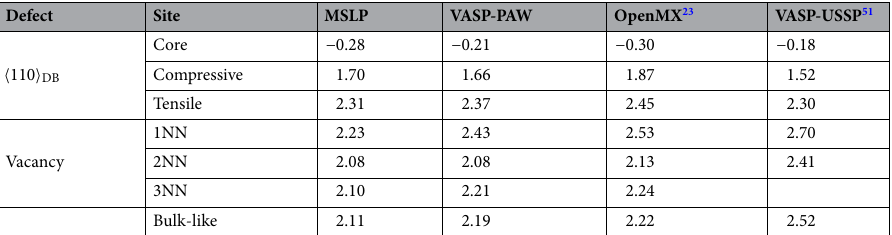
Table 2. Magnetic moments in the vicinity of a configurations. The core, compressive and tensile sites refer to the positions defined in the inset of Fig. 2. They are all in unit of Bohr magneton ( µ B ). Bulk-like refers to atoms far from the defect